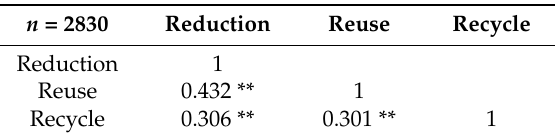
Table 5. Correlation matrix.